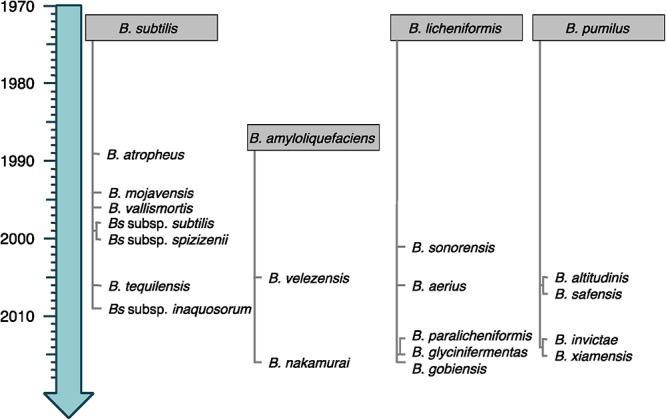
Timeline emergence of the species from the B. subtilis group. The species are classified following their relatedness to the closest original member of the group (gray boxes). Heterotypic synonyms are not shown.